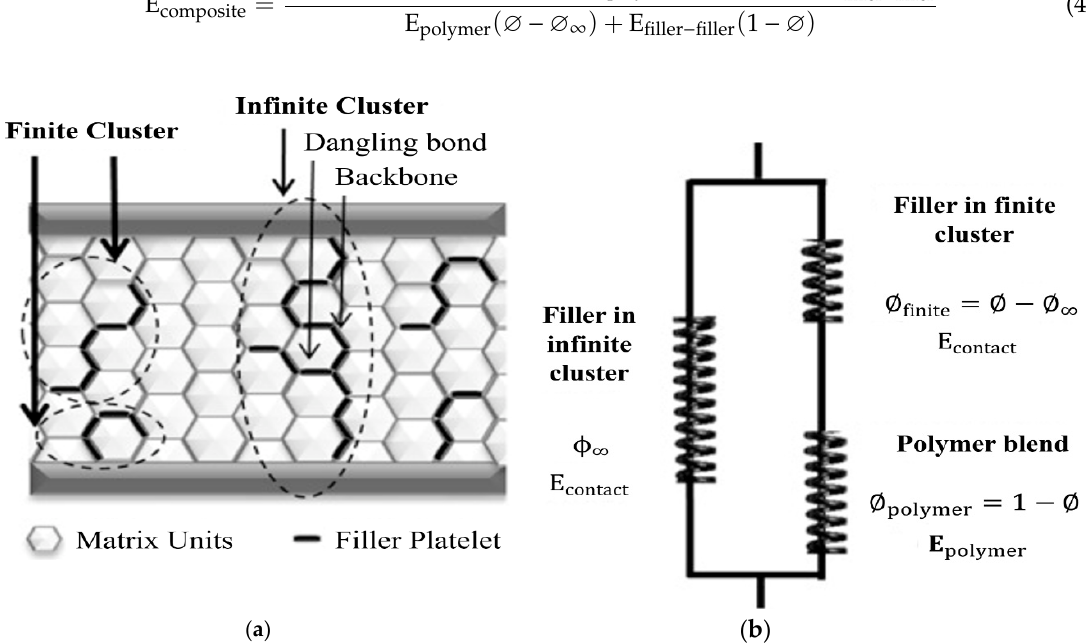
Figure 8. Schematic of finite and infinite clusters with a percolation concept ( a ), and series/parallel springs model for mechanical response of the percolated composite ( b ) [29].